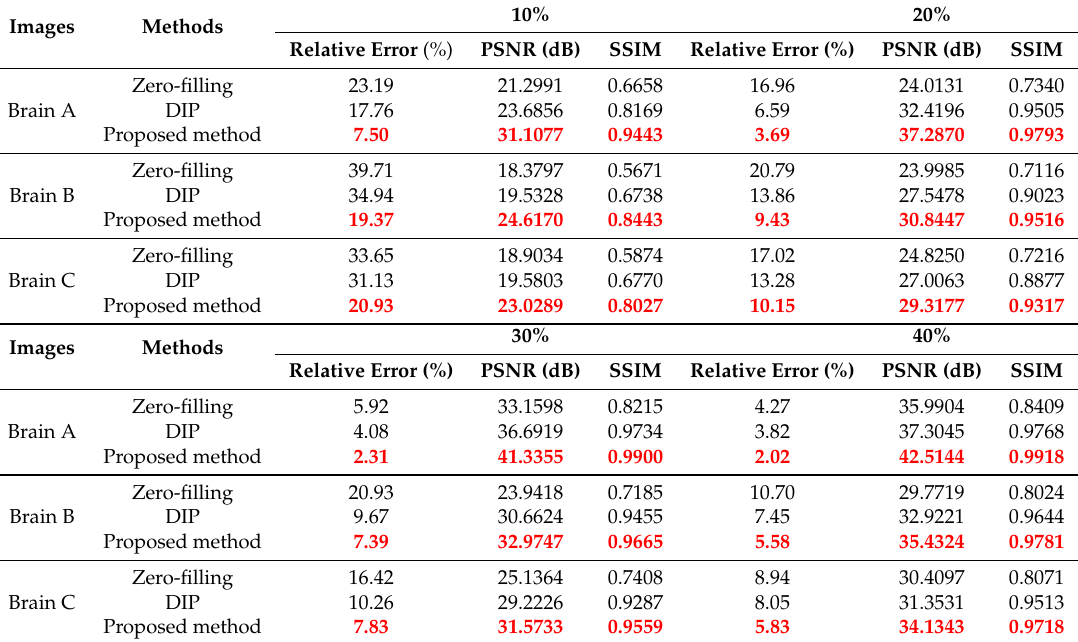
Table 2. Relative errors, PSNR, and SSIM values of reconstruction by different methods under the Cartesian undersampled mask.